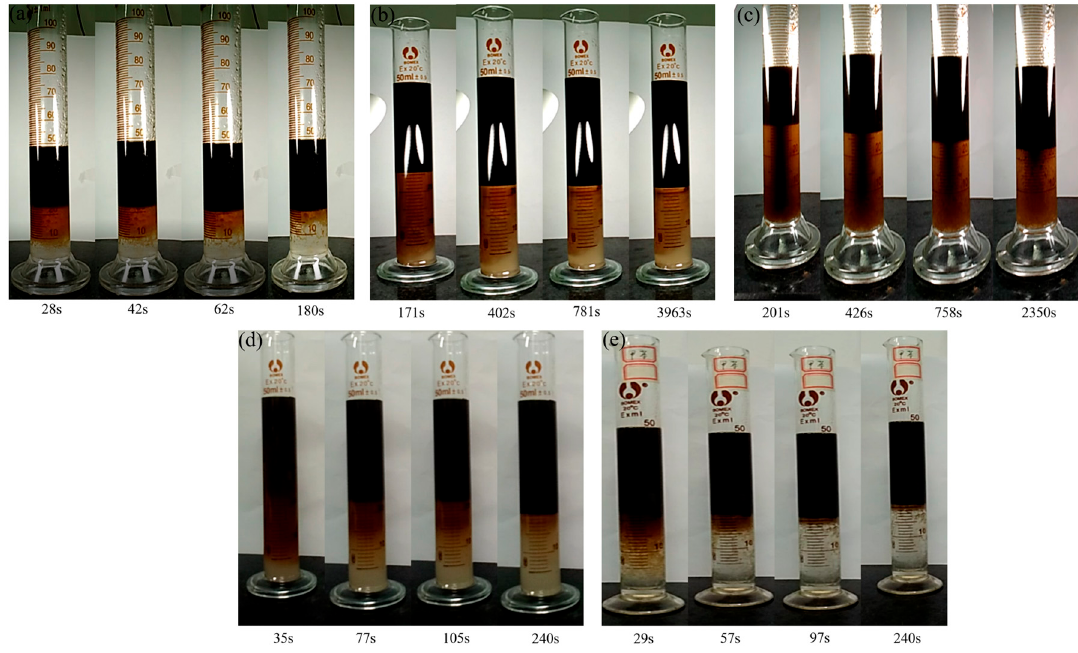
Figure 7. Visual appearance of emulsions at room temperature ( a ) without asphaltenes, SHT, and Et 3 N; ( b ) asphaltenes (1.7 g/L); ( c ) SHT (11%) and asphaltenes (1.7 g/L); ( d ) Et 3 N (2.2%); ( e ) SHT (2.2%).